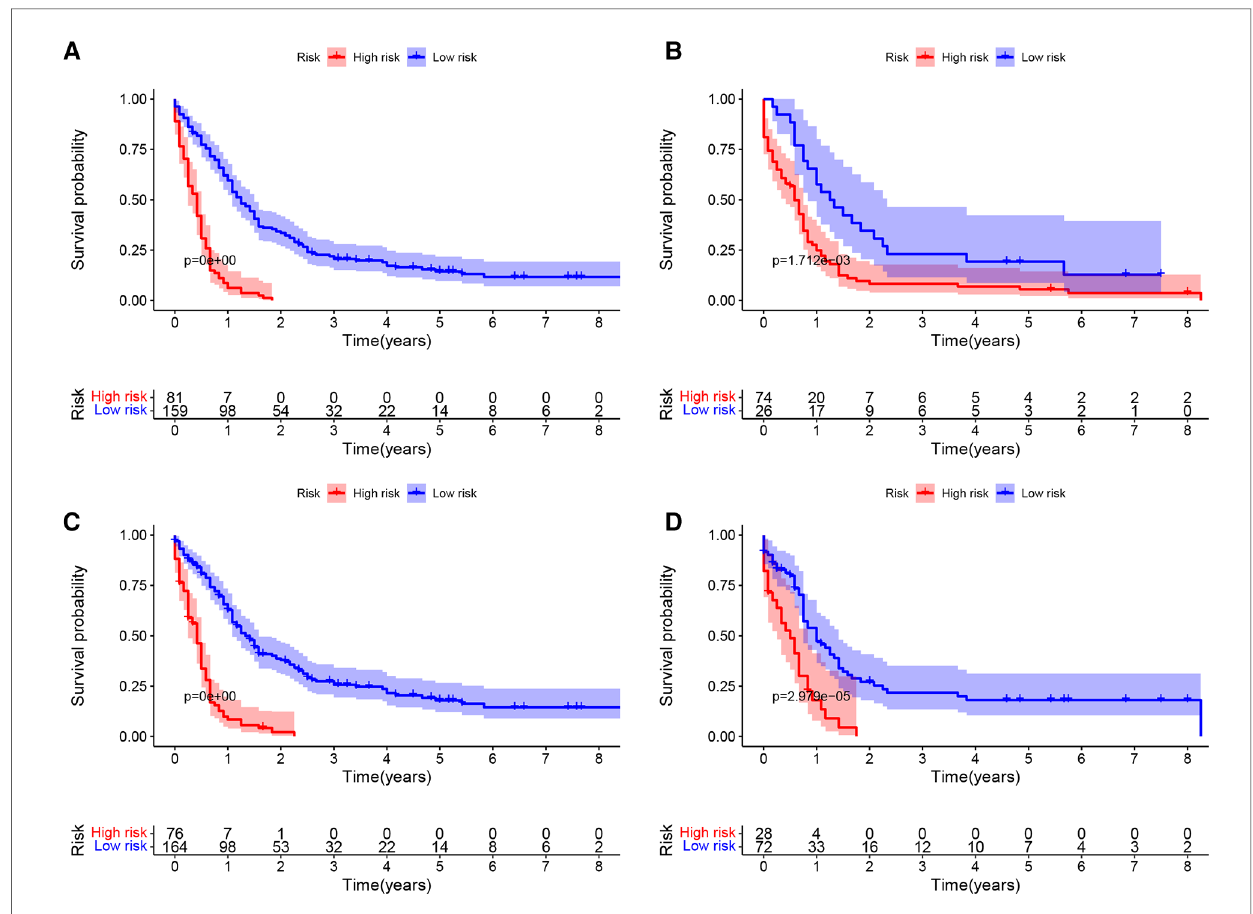
FIGURE 8 Kaplan – meier curves of OS and CSS of NEPC patients by different risk levels. OS in training set ( A ) and validation set ( B ); CSS in training set ( C ) and validation set ( D